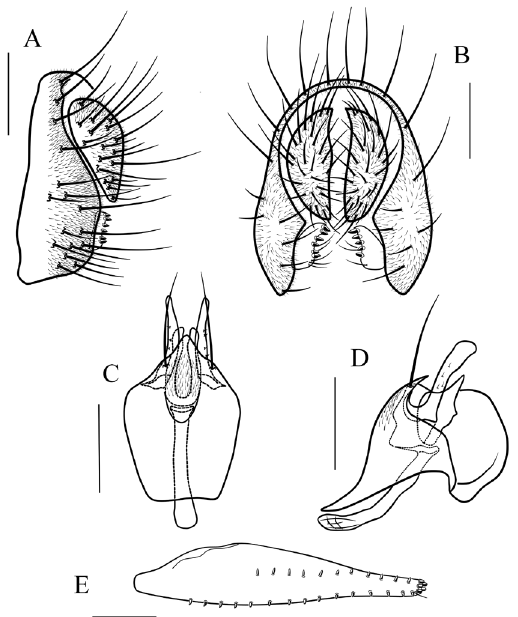
Figure 15. Scaptodrosophila obscurata sp. n. A, B epandrium, surstylus and cercus (lateral and posterior views) C, D hypandrium, parameres, gonopods, aedeagus and aedeagal apodeme (ventral and lateral views) E oviscapt (lateral view). Scale bars 0.1